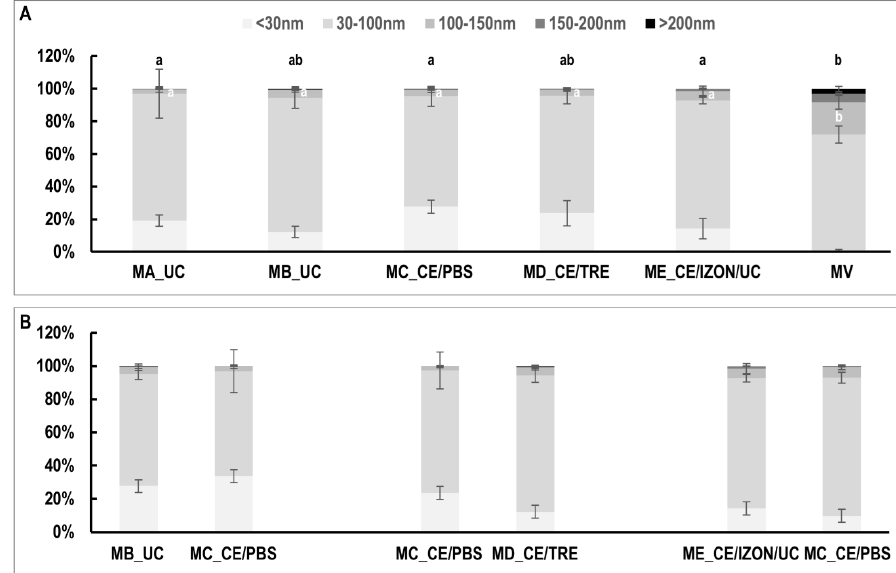
Figure 3. Comparison of extracellular vesicles (EVs) size distribution among isolation methods. ( A ) EVs size distribution among all different EVs isolation methods examined. ( B ) Two-by-two comparisons of EVs size distribution of methods MB with MC, MC with MD, and MC with ME, using uterine lavage samples from the same mares for each comparison. MA_UC: EVs obtained by Method A, ultracentrifugation (UC) 100,000 g (2×) 90 min using fixed angle rotor and Beckman bottles; MB_UC: UC with swing-out rotor and Beckman tubes; MC_CE/PBS: ultrafiltration by using Centricon filters followed by a washing step with PBS; MD_CE/TRE: similar to C but washing step with PBS/25 mM trehalose; ME_CE/IZON/UC: EVs obtained by the combination of CE, followed by SEC, Izon qEV columns and concentration of EVs fractions by UC; MVs: microvesicles obtained after centrifugation at 12,000 g for 30 min. Data are represented as mean with the error bars, indicating the standard error of the mean (SEM). Different letters indicate significant differences among EVs isolation methods within a specific EVs size range (100–150 and >200) (a,b: p < 0.05).